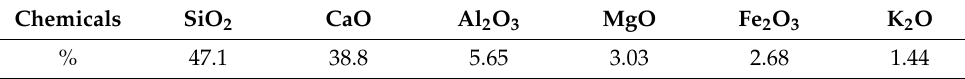
Table 3. Chemical composition analysis results of